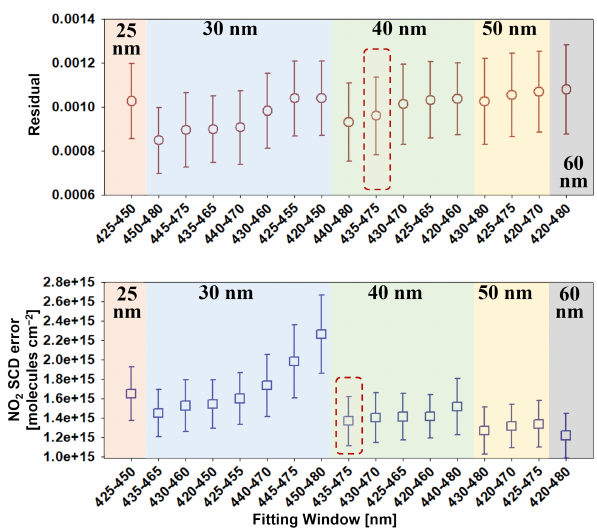
CMAQ calculation over the reference sector (i.e., 6 . 75